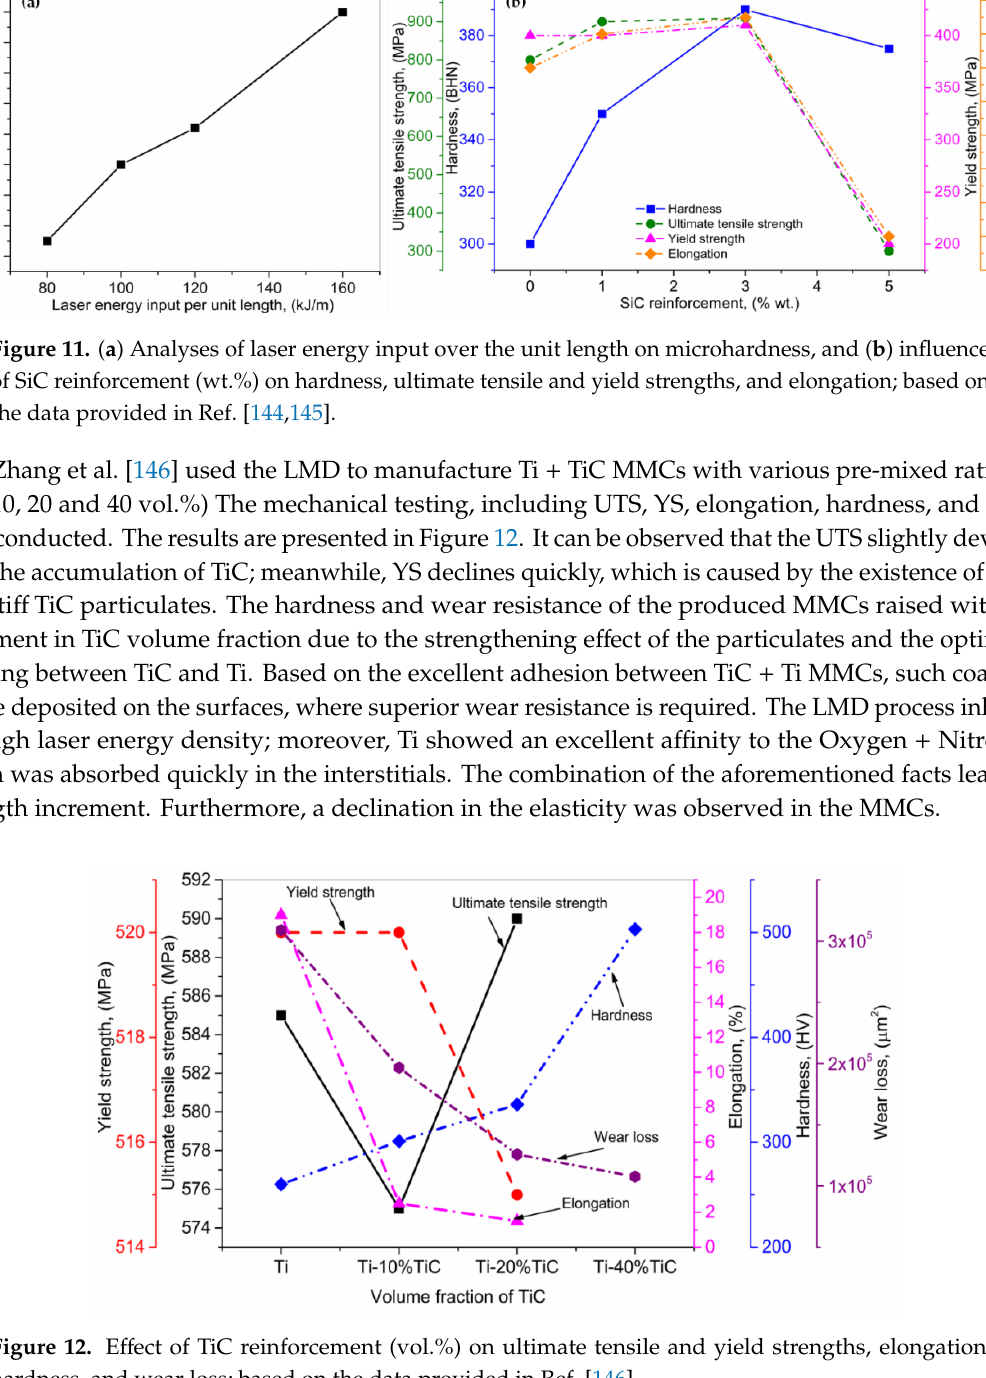
Table 7. Summary of MMCs mechanical properties.